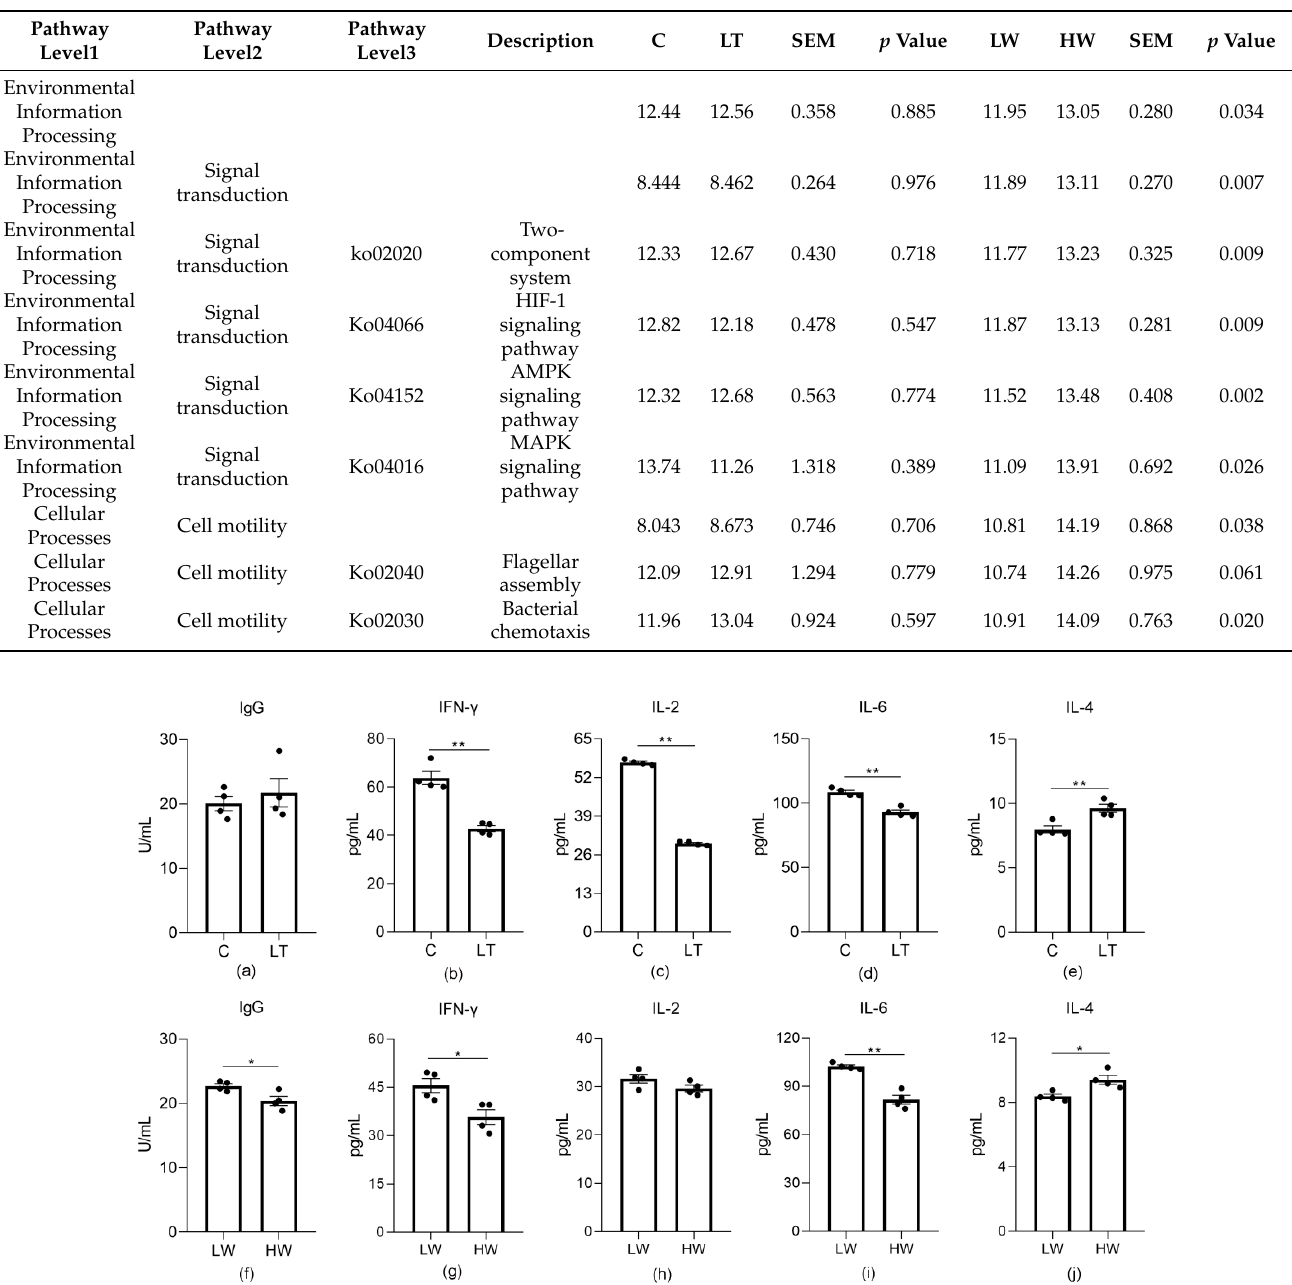
Table 2. The functional predictions for rumen microbes under the cold stress (%).